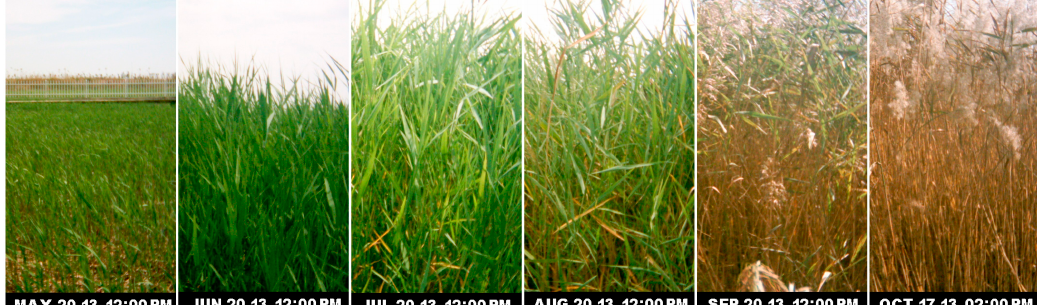
Figure 1. Phenological phase of Phragmites communis . Table 1. Soil physical chemical properties.